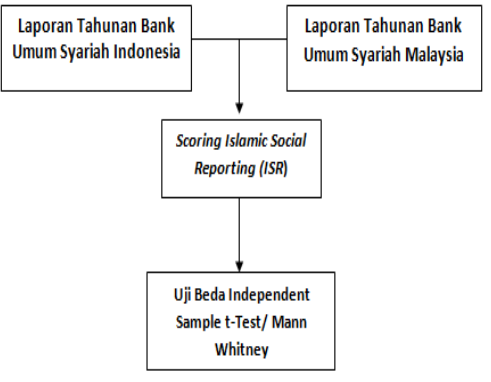
Figure 1 Analysis